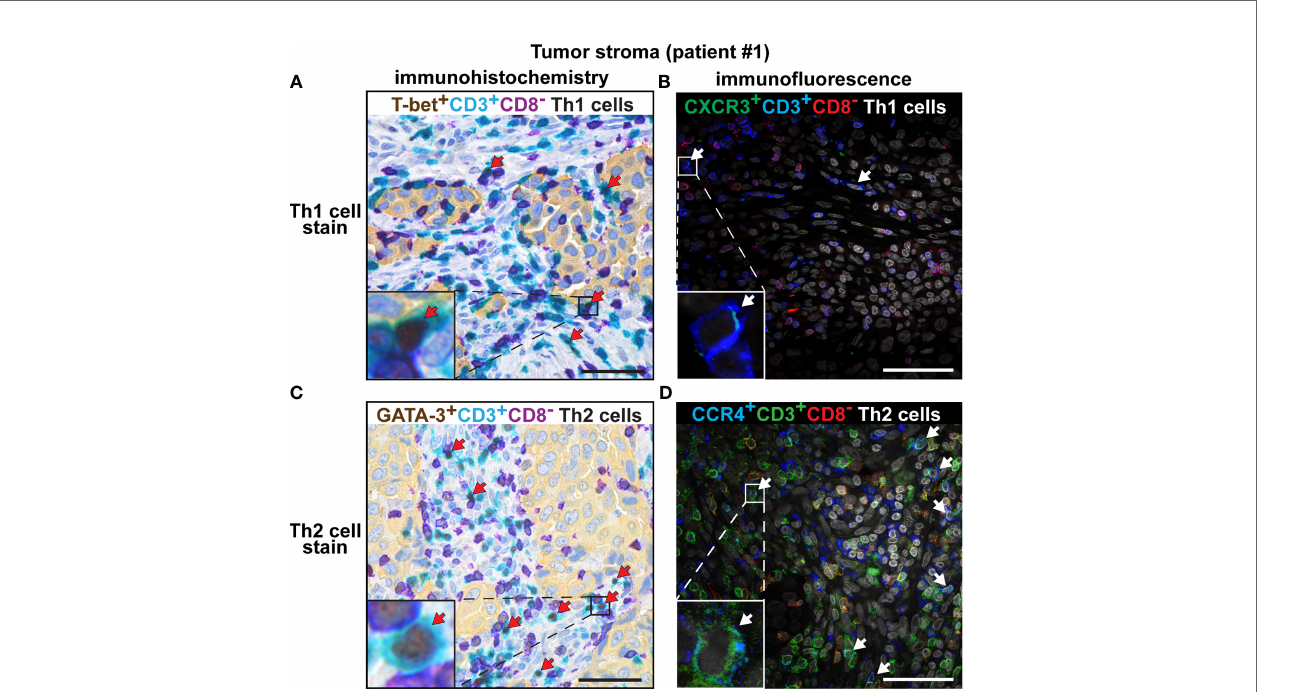
FIGURE 7 | Comparison of the number of intratumoral Th1 and Th2 cells detected by chromogenic IHC vs. immuno fl uorescence. Representative images of immunostained tumor sections from one patient with lung adenocarcinoma. Boxed areas are enlarged and presented as corner insets. The positive cells for each Th subset in tumor stroma are indicated by red or white arrows. (A) Th1 cells (T-bet + CD3 + CD8 - ) detected by chromogenic IHC. (B) Th1 cells (CXCR3 + CD3 + CD8 - ) detected by immuno fl uorescence. (C) Th2 cells (GATA-3 + CD3 + CD8 - ) detected by chromogenic IHC, using the anti-GATA-3 mAb clone L50-816. (D) Th2 cells (CCR4 + CD3 + CD8 - ) detected by immuno fl uorescence. Similar results were obtained from all three investigated NSCLC patients. Original magni fi cation, 600x. Scale bars, 50 m